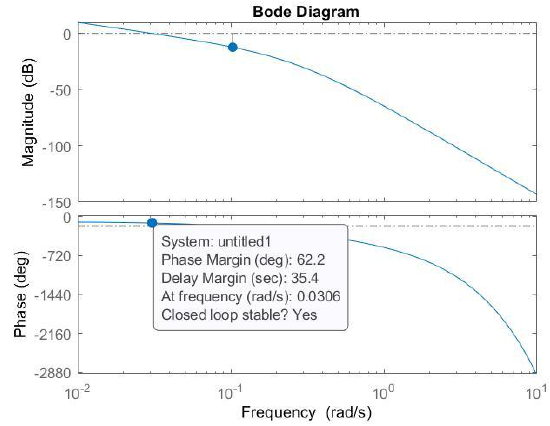
Figure 4. Bode diagram of the open-loop system for the third designed PI controller. The corresponding step responses of the closed-loop system are plotted in Figure 5.